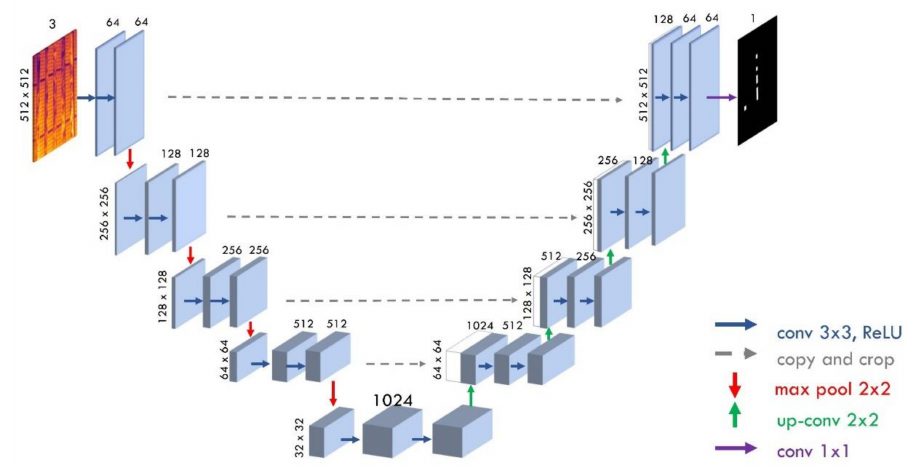
Figure 4. Framework of U-Net architecture for semantic